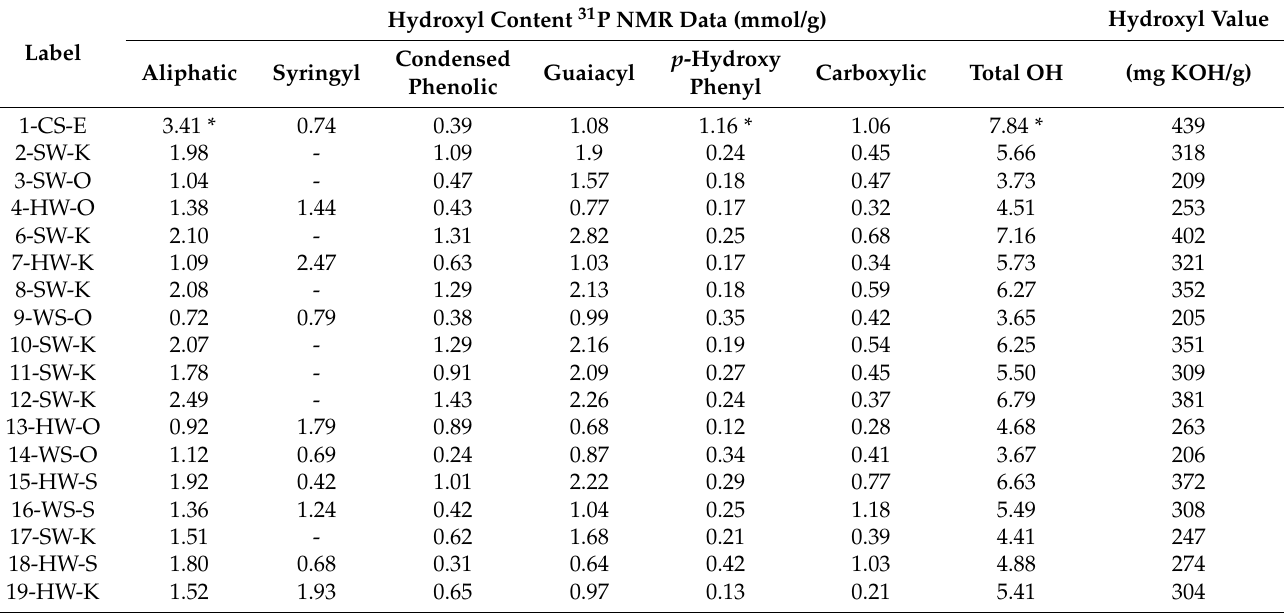
Table 2. Hydroxyl content determination results of lignin